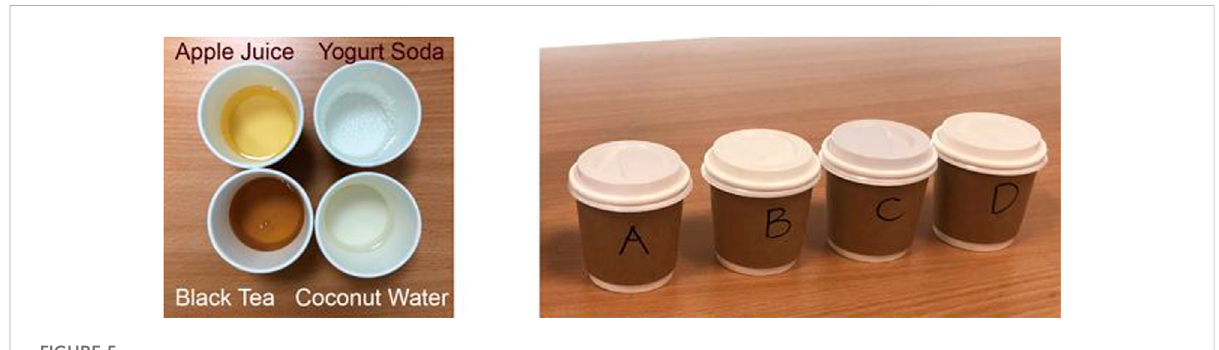
FIGURE 5 Tastant choices and the container of the